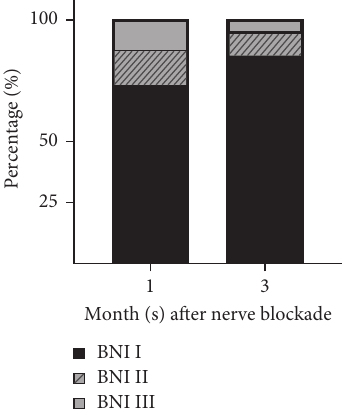
Figure 3: Pain intensity at 1 and 3 month(s) after occipital nerve blockade. BNI: Barrow Neurological Institution pain